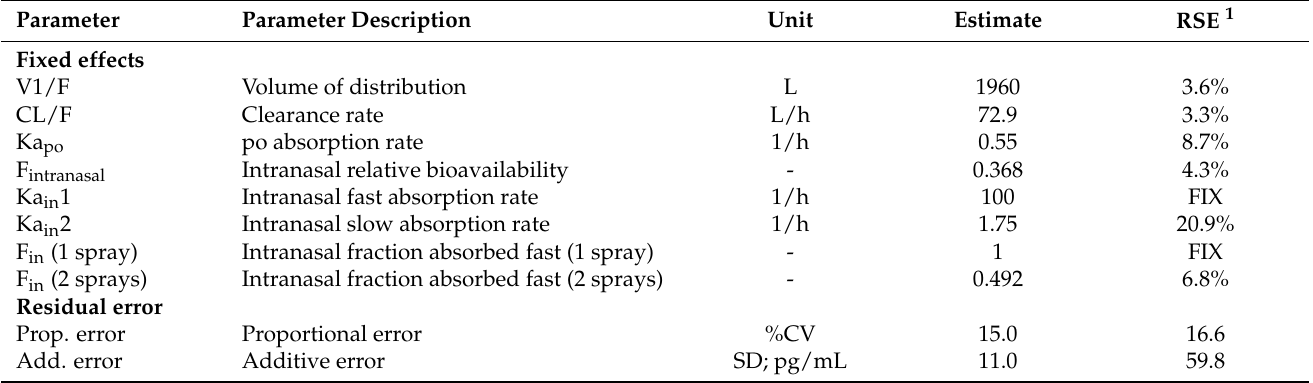
Table A2. Parameter estimates of the azelastine PK model A. No inter-individual variability (IIV) was estimated, as the mean curves of azelastine plasma concentrations could be described accurately without additional